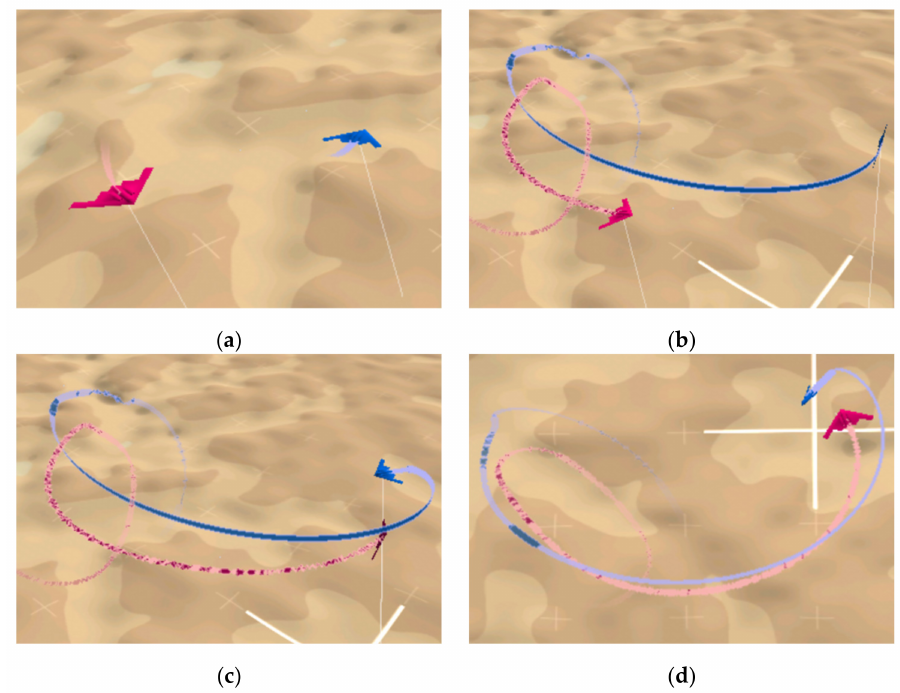
Figure 18. Real-time display example of air combat confrontation: ( a ) early stage of air combat; ( b ) medium stage of air combat; ( c ) later stage of air combat; ( d ) top view of the air